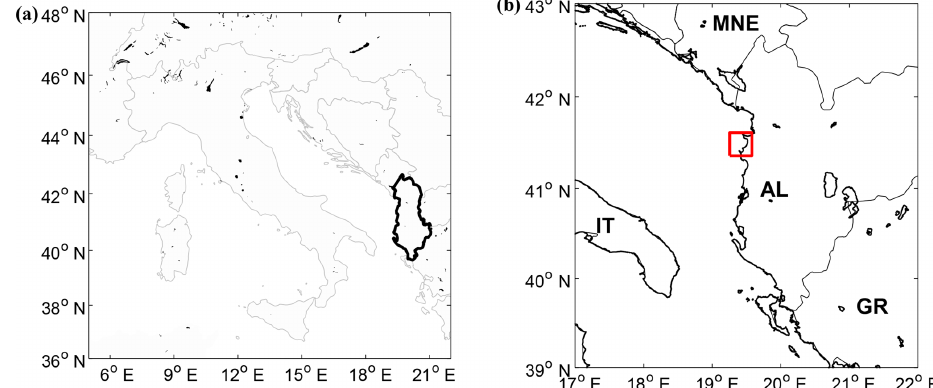
Figure 1. Map showing the area under investigation. (a) Location of Albania in southeastern Europe and (b) the Bay of Lalzit underlined within the red frame.